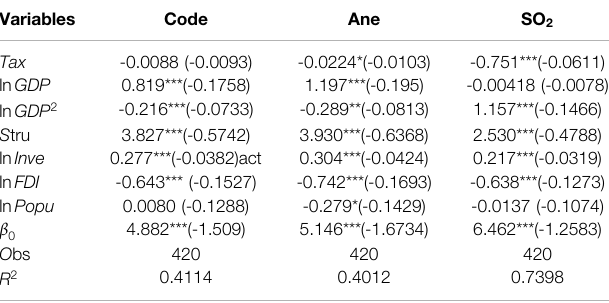
TABLE 2 | Return results of the full sample of environmental taxes and fees and three types of pollutant emissions in 30 provinces and cities in